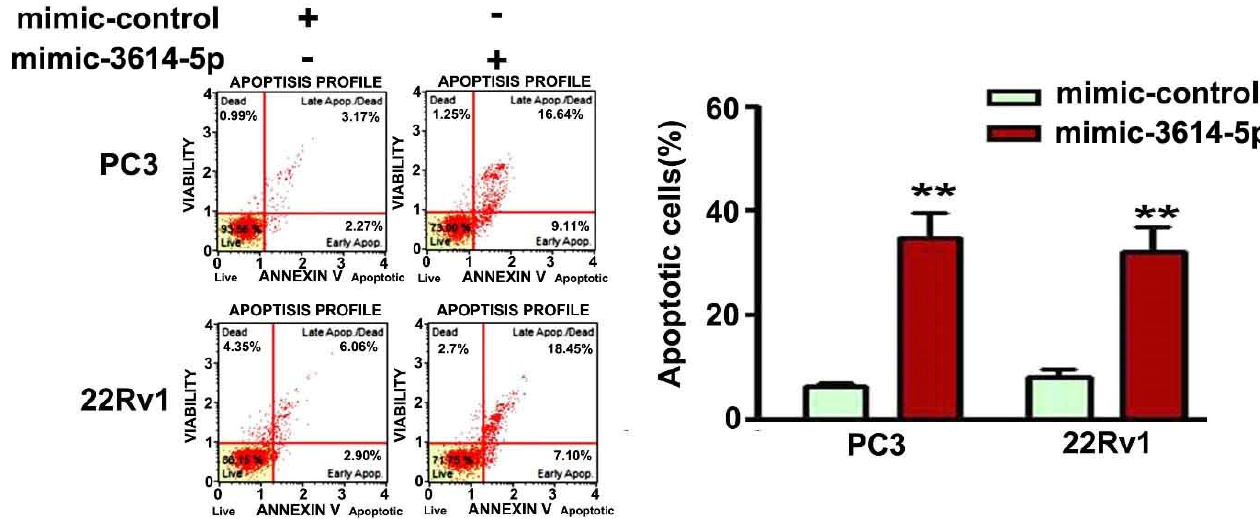
Figure 4 . Effect of miRNA-3614-5p on apoptosis induction in human PC3 and 22Rv1 prostate cancer cells. Regulation of apoptosis induction in human PC3 and 22Rv1 prostate cancer cells transfected with mimic-control or mimic-3614-5p were analyzed by Annexin V/PI staining through flow cytometry. Mimic-control as the control group. **, p < 0.01 versus control (mean ± SE, n = 3). Y-axis presents the cell viability (%) of normal healthy cells (LL), early and apoptotic cells (LR/UR) and necrotic cells (UL). Mimic-3614-5p as mimic miRNA-3614-5p